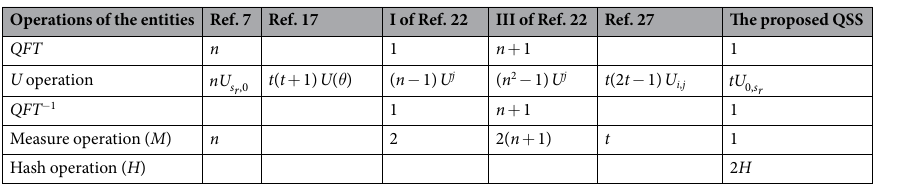
Operations of the entities Ref. 7 Ref. 17